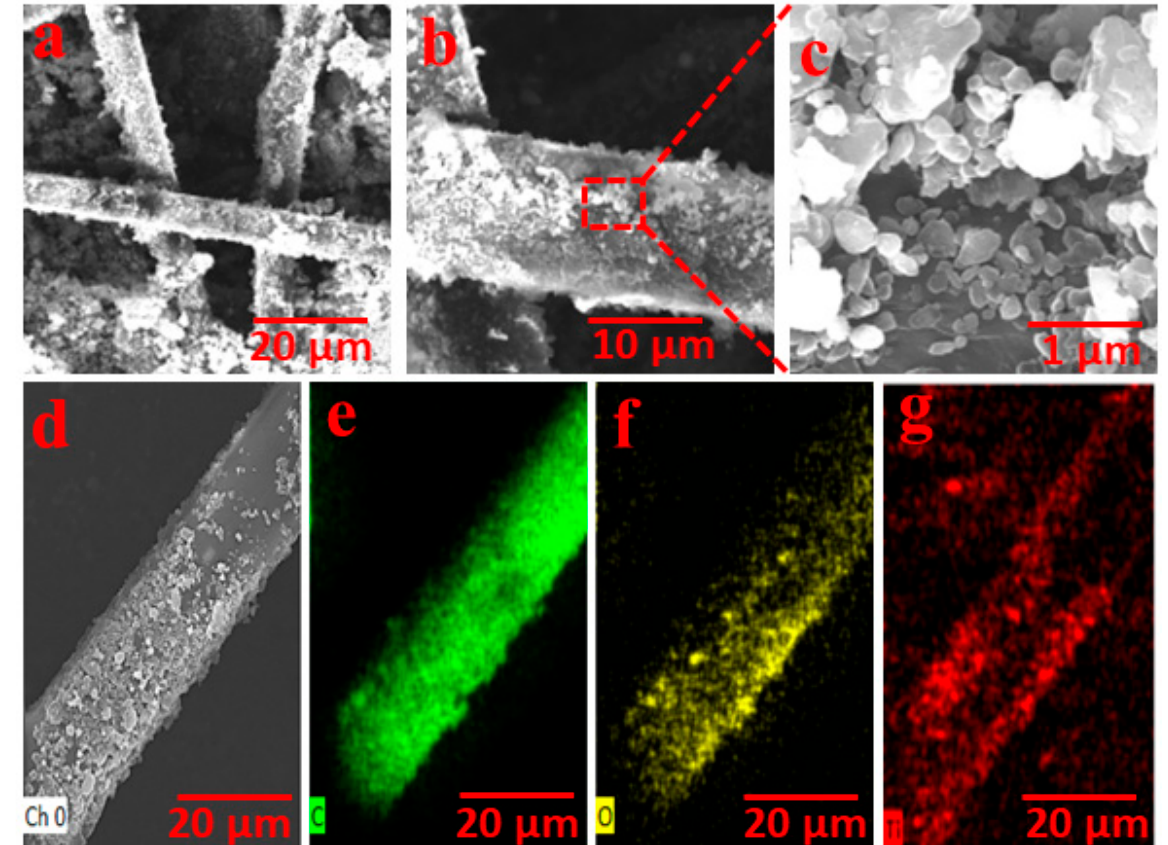
Figure 3. The structural and morphological investigations of TiO 2 /AC-based solar evaporator. FESEM images of the ( a ) TiO 2 /AC deposited cotton surface showing rugged surface texture intensified pitch-black color on hydrophilic nodes of cotton fabric. ( b ) Homogenized coating on TiO 2 /AC on a single thread. ( c ) FESEM image of TiO 2 /AC nanocomposite embedded on the surface of cotton fabric. ( d – g ) EDS mapping of TiO 2 /AC embedded cotton fabric.